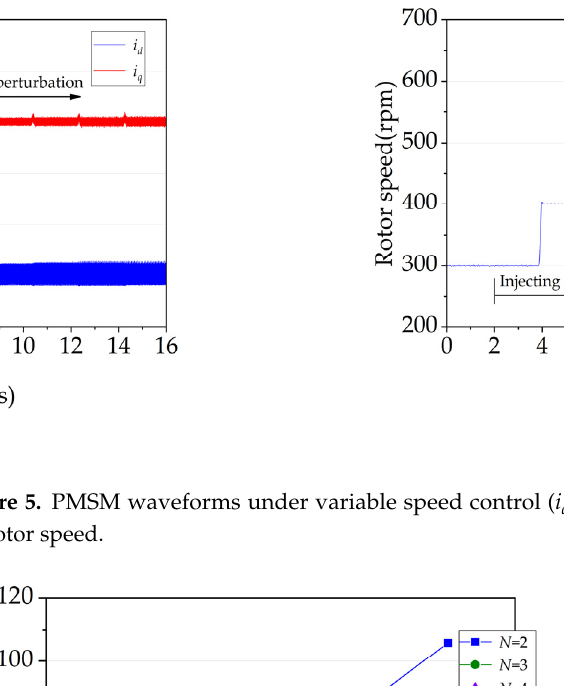
Figure 5. PMSM waveforms under variable speed control ( i d = 0, i q = 3 A). ( a ) Dq − axis currents; ( b ) rotor speed.